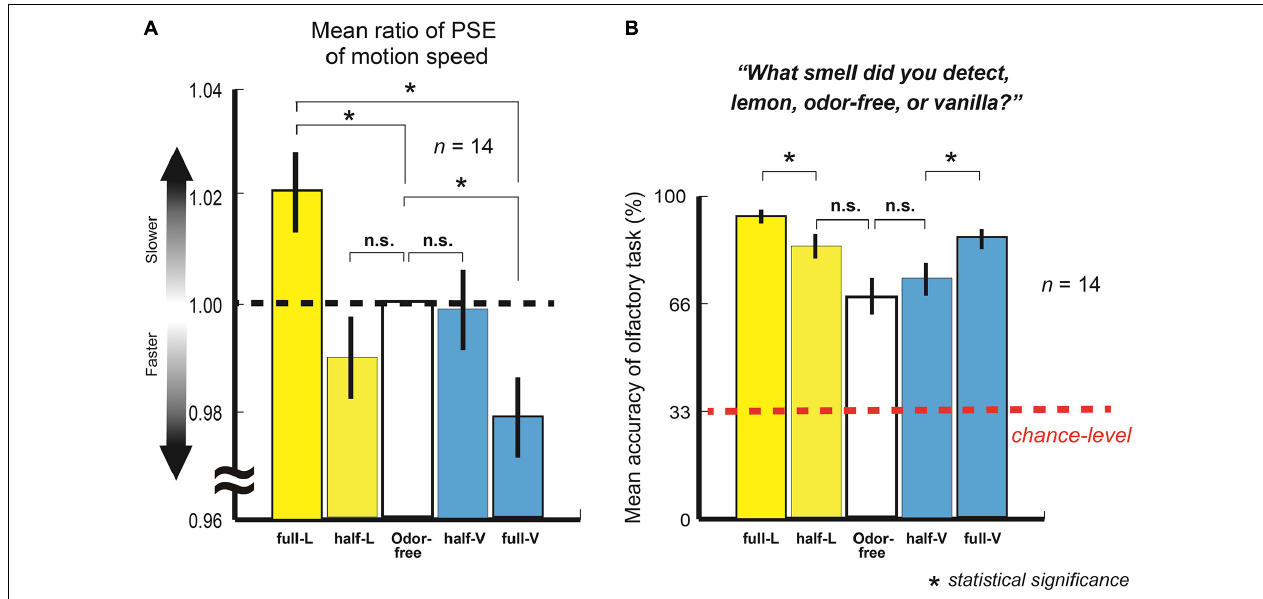
FIGURE 2 | (A) Mean ratio of point of subjective equality (PSE) of motion speed with full-lemon, half-lemon, half-vanilla, and full-vanilla to PSE of odor-free. Error bars show standard errors. Participants perceived slower moving dots with lemon than with odor-free or vanilla even when stimuli were presented at identical motion speed. (B) Mean accuracy of olfactory task for full-lemon, half-lemon, odor-free, half-vanilla, and full-vanilla. Error bars show standard errors. Red dashed line represents chance-level accuracy (33.3%